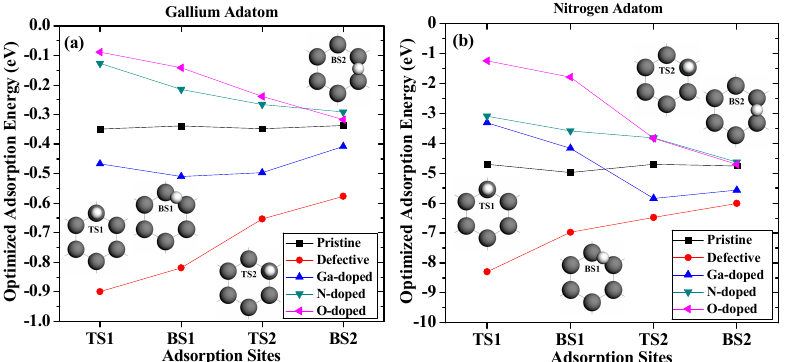
Figure 5. The values for the diffusion barriers of the ( a ) gallium and ( b ) nitrogen adatoms.